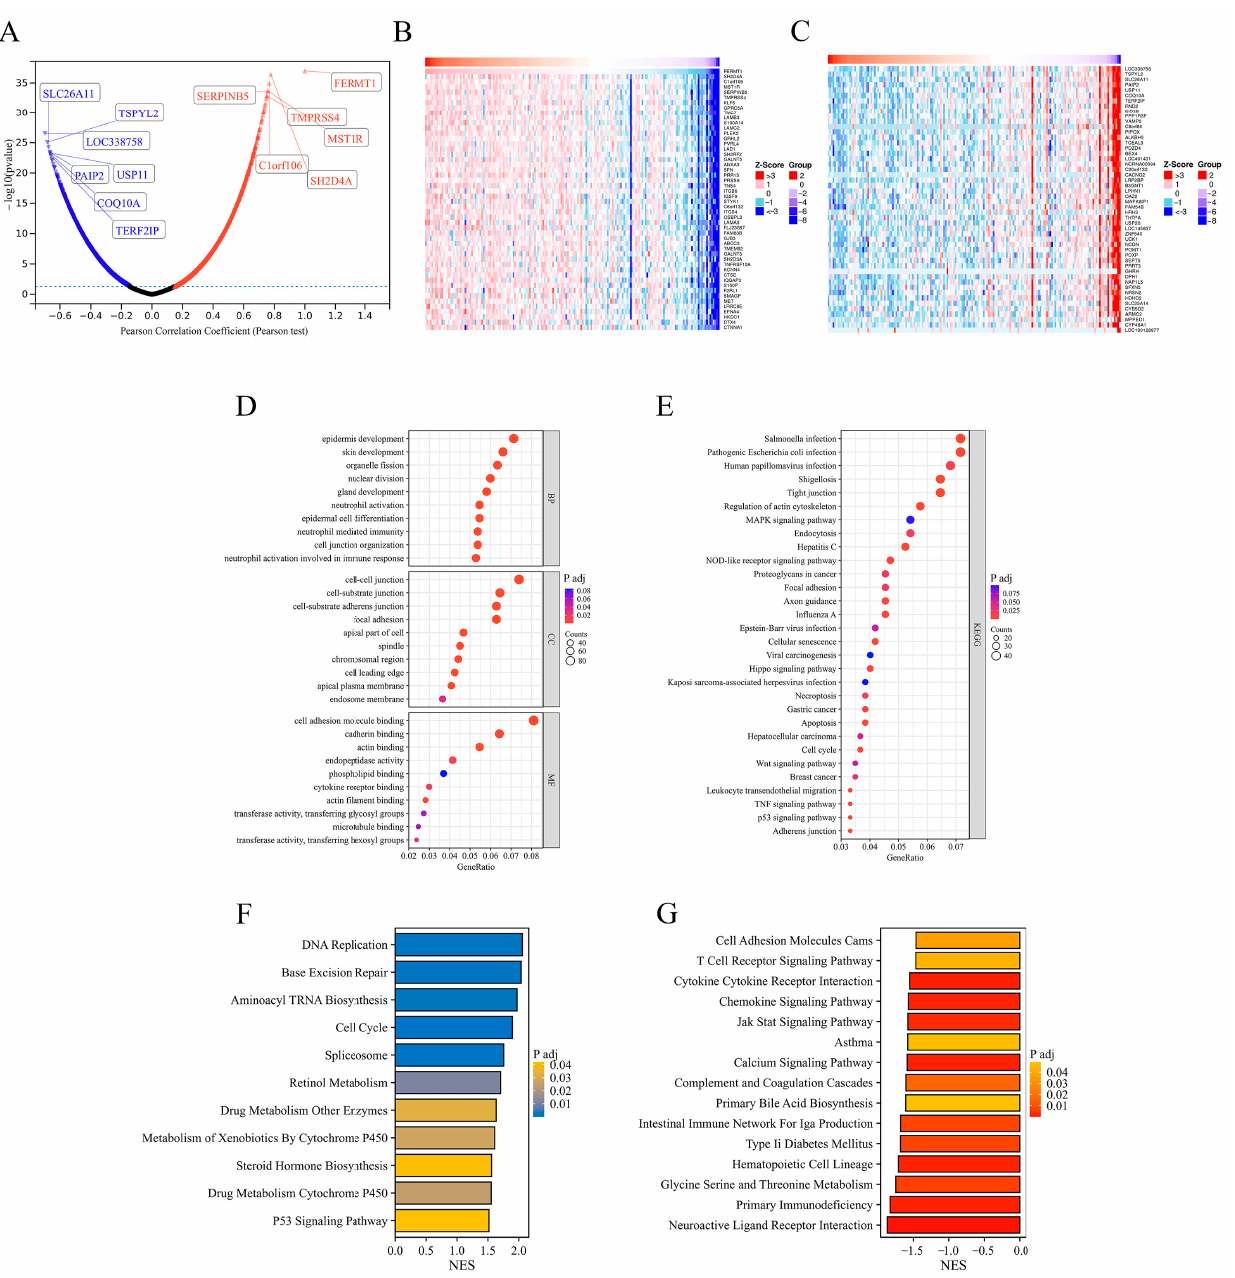
Figure 6. Functional enrichment analysis of FERMT1 co-expression genes in PAAD. ( A ) The volcano map of genes differentially expressed in correlation with FERMT1. ( B ) The top 50 positive co- expression genes. ( C ) The top 50 negatively co-expression genes. ( D ) The GO analysis of co-expression genes in molecular function (MF), cellular component (CC), and biological process (BP). ( E ) KEGG pathway analysis of co-expression genes. ( F ) GSEA enrichment analysis in high FERMT1 expression group. ( G ) GSEA enrichment analysis in low FERMT1 expression